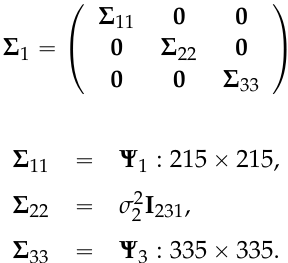
Table 1. Adjusted Frobenius norm distances between S ˚ and Σ 1 .